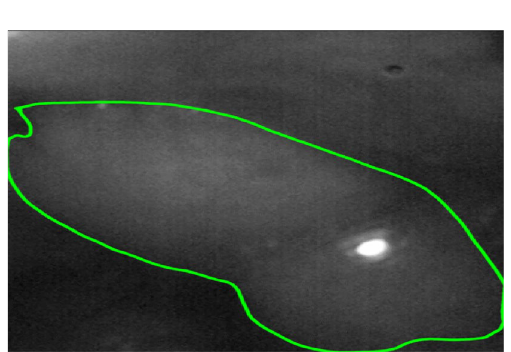
Figure 5. Example mouse image. The margin of the neoplastic lesion is marked in green.